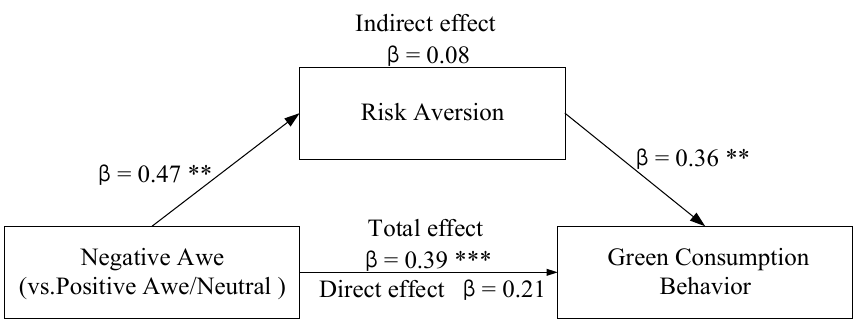
Figure 2. Mediation analysis of risk aversion. ** p < 0.01, *** p < 0.001.